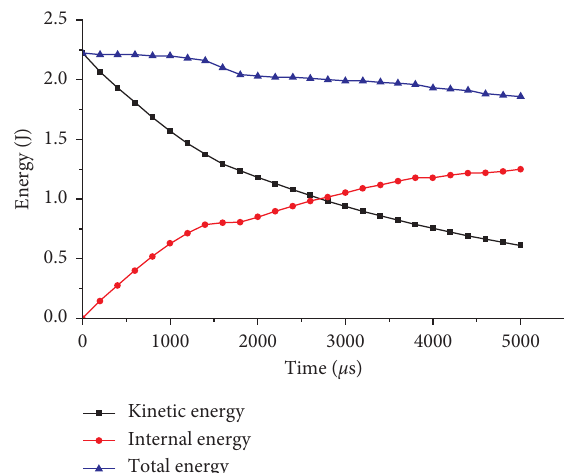
Figure 7: Energy time history at a velocity of 2m/s.